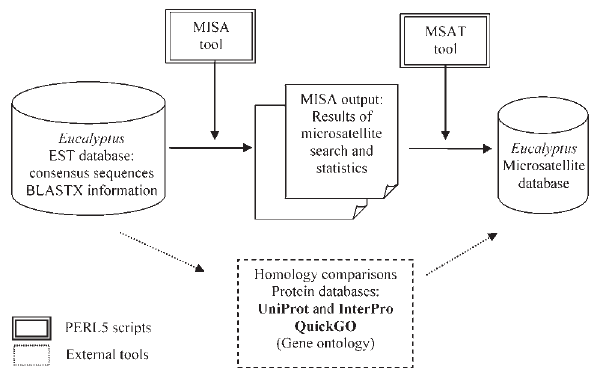
Figure 1 - The generation of the Eucalyptus EST-derived microsatellites database. (EST = expressed sequence tag, BLASTX = homology compar-